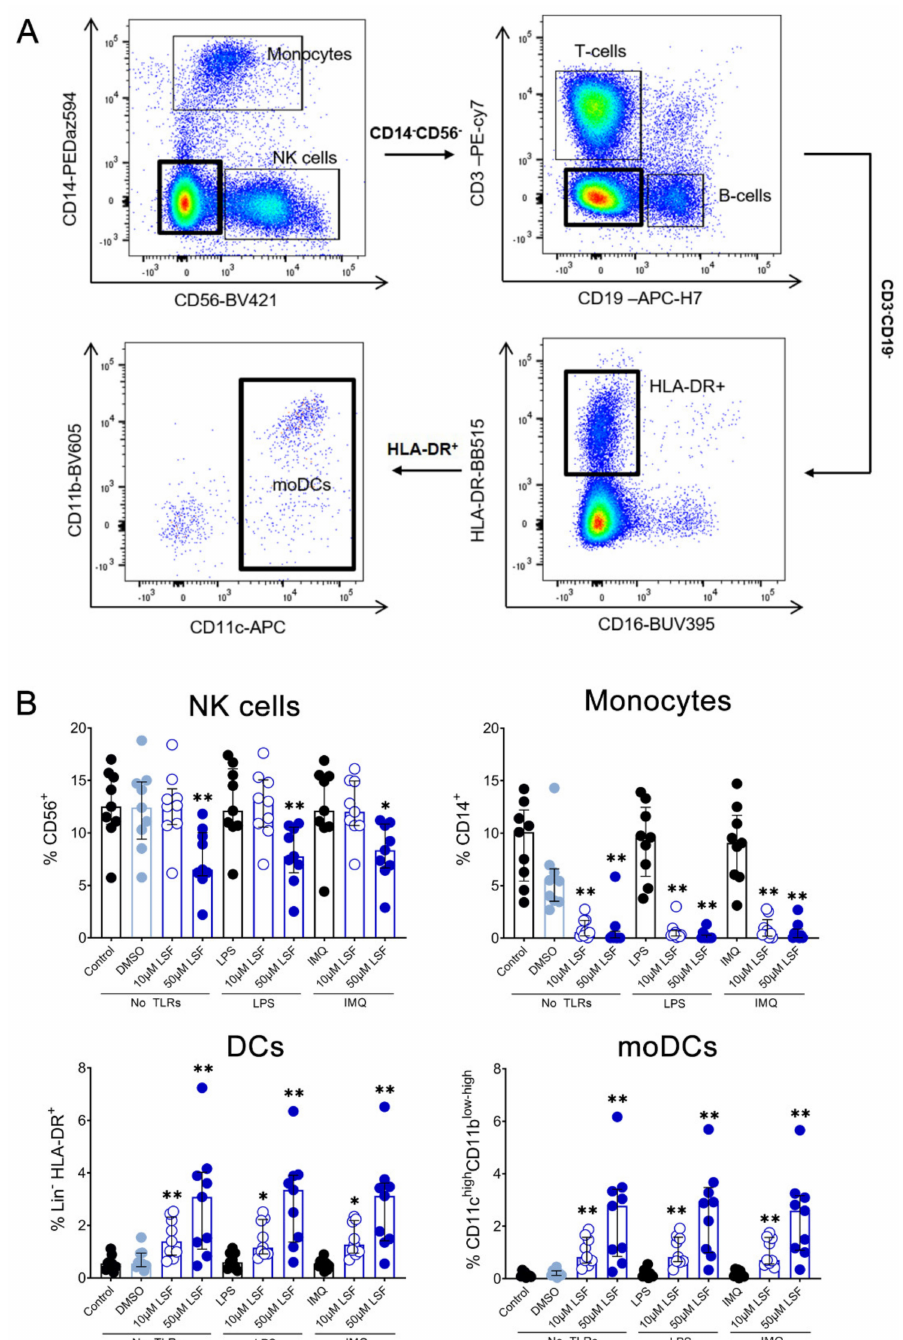
Figure 3. The effect of LSF on innate immune cell populations. Gating strategy ( A ) and flow cytometric results ( n = 9) are displayed as a proportion of total lymphocyte populations ( B ). The median ± IQR is displayed. The medium control was used as the control group for comparisons with the TLR-stimulated groups; the DMSO control was used as the vehicle control for comparison with the LSF treatments. * p < 0.05, ** p < 0.01 compared to the respective untreated control using